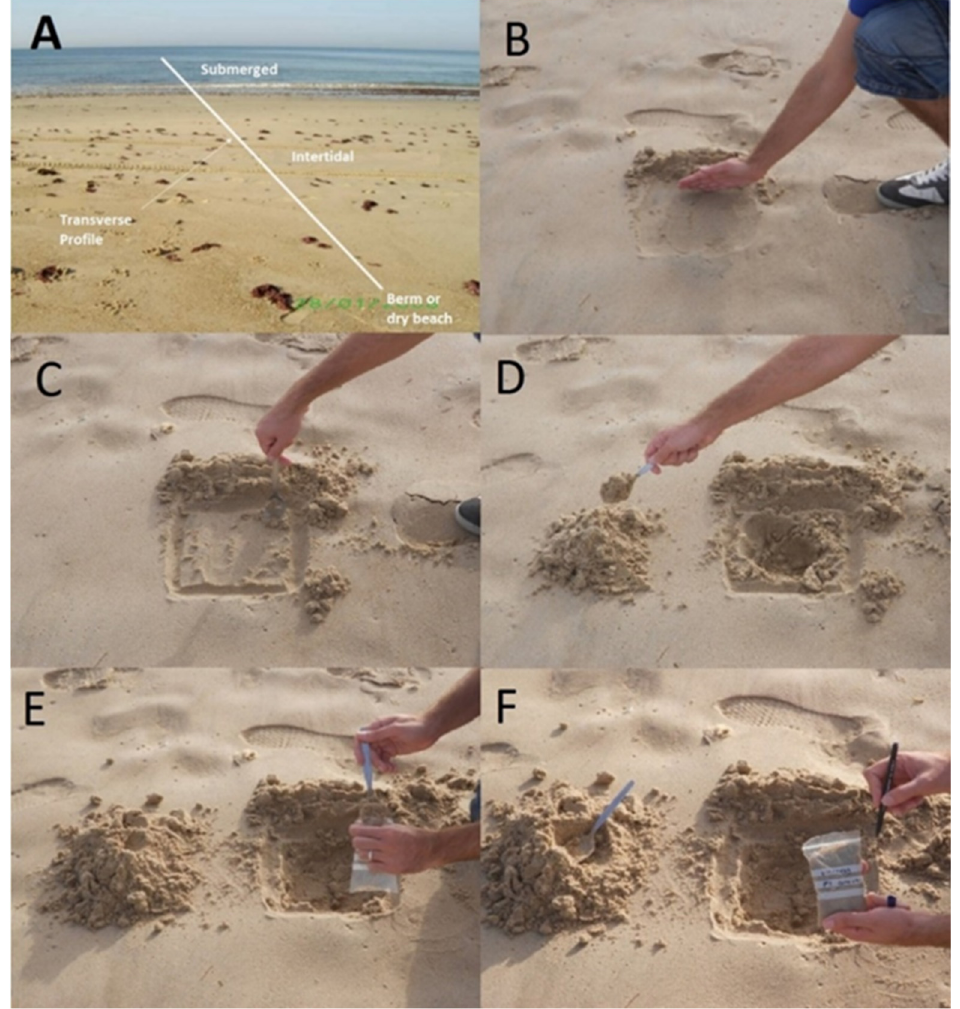
Figure 5. Methodology proposed by [37] for beach sand sampling. ( A ): profile with different levels; ( B ): elimination of the first layer because of bioclasts; ( C ): drawing of the 20 cm square for extraction; ( D ): excavation and production of a pile adjacent to the sampling pit; ( E ): mixing and sampling; ( F ): labelling).